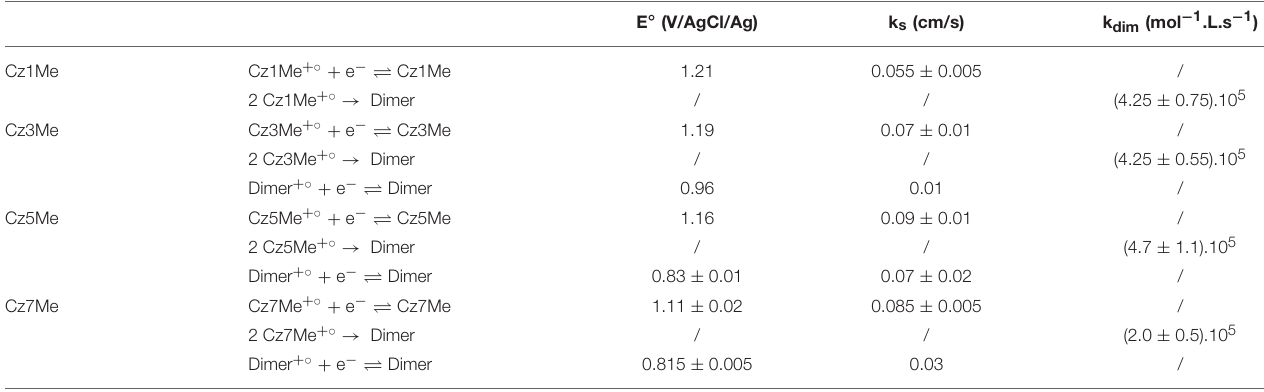
TABLE 1 | Formal potential (E ◦ ), heterogeneous rate constant (k s ) and dimerization rate (k dim ) of Cz1Me, Cz3Me, Cz5Me, and Cz7Me deduced from fast electrochemistry experiments and corresponding